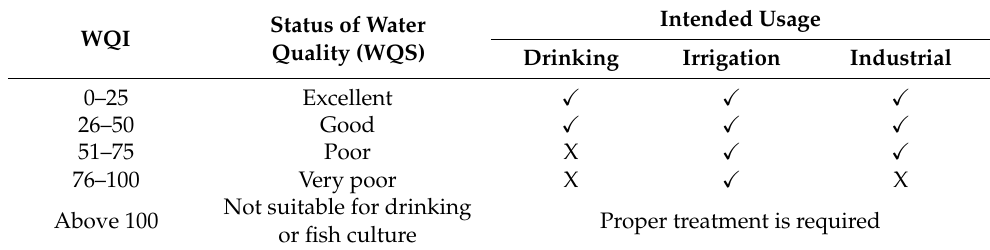
Table 1. Recommended range of WQI for intended usage: [32].